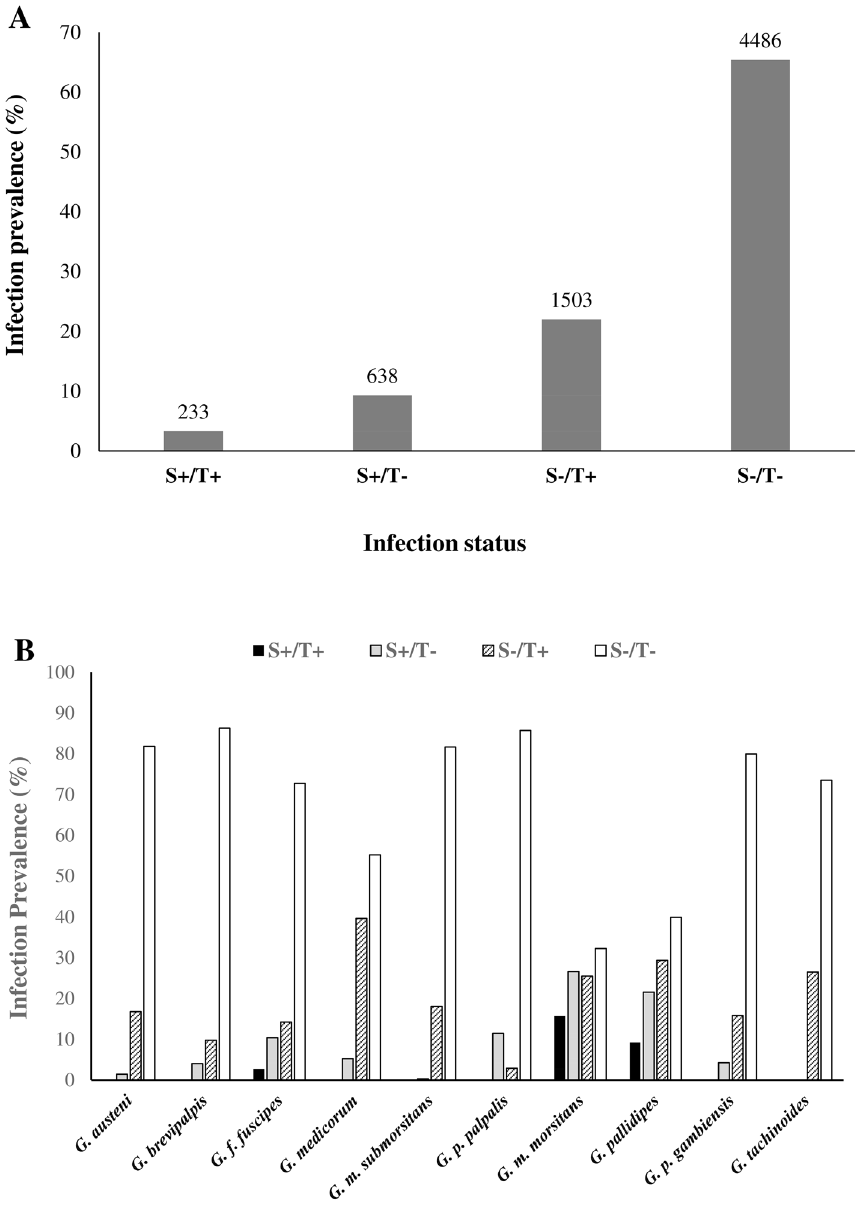
Figure 3. Prevalence of coinfection of Sodalis and Trypanosoma infection in wild tsetse populations. ( A ) Prevalence of coinfection, ( B ) prevalence of coinfection by tsetse